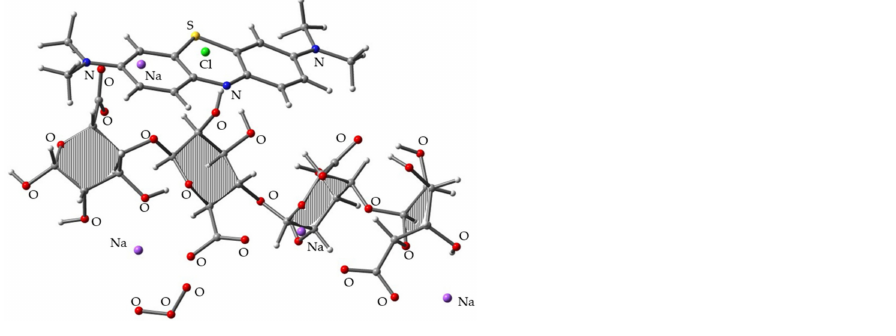
Figure 4. Optimized molecular structure obtained for the trimolecular complex of MB/SA (1) and O 3 at the B3LYP/6-31G(d) level.